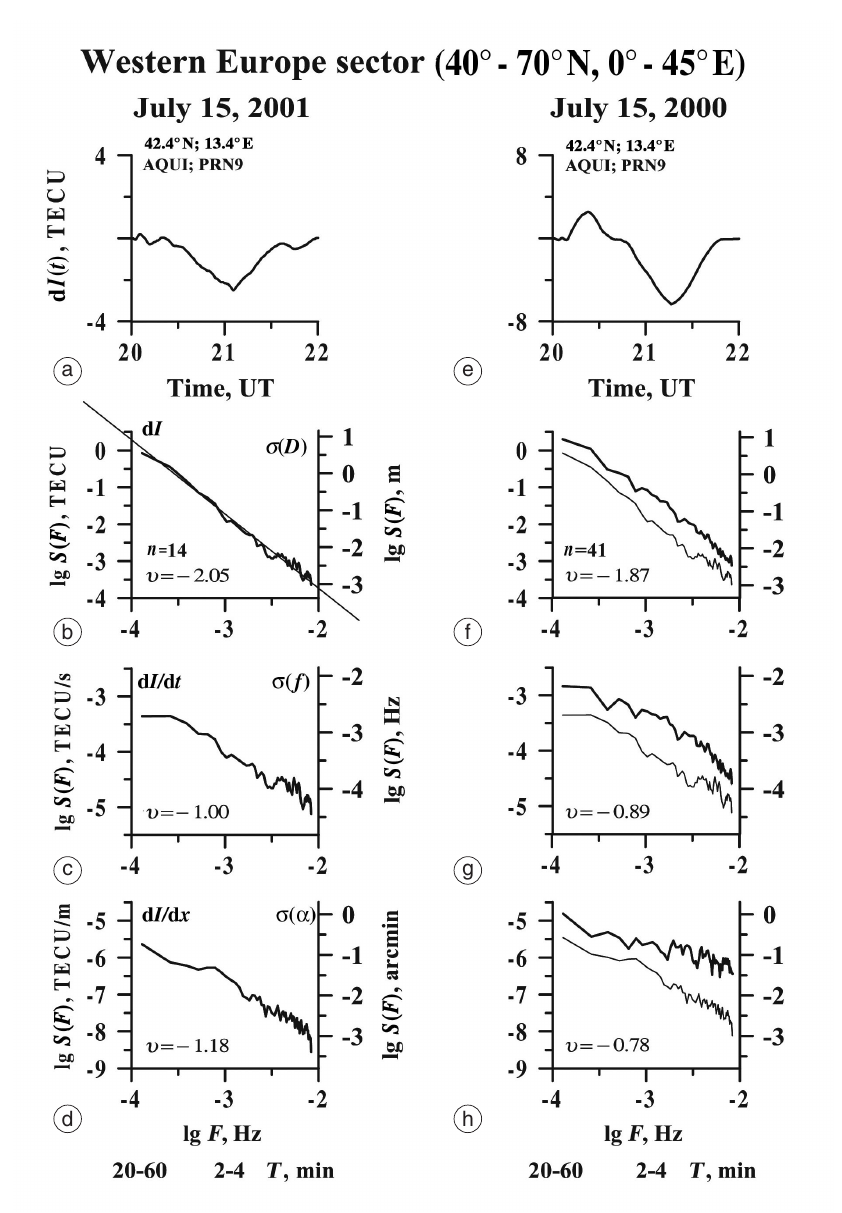
Fig. 6a-h. The dependence of errors of σ ( D ), σ ( f ) and σ ( α ) for the Western Europe sector. TEC variations dI ( t ), logarithmic scale amplitude spectra S ( F ) of TEC fluctuations and derivatives (left scale in the panels b-d and f-h), and the fluctuation spectra of σ ( D ), σ ( f ) and σ ( α ) converted to the working frequency of 300 MHz (right scale in the panels b-d and f-h) for the magnetically quiet day of July 15, 2001 (on the left) and a major magnetic storm of July 15, 2000 (on the